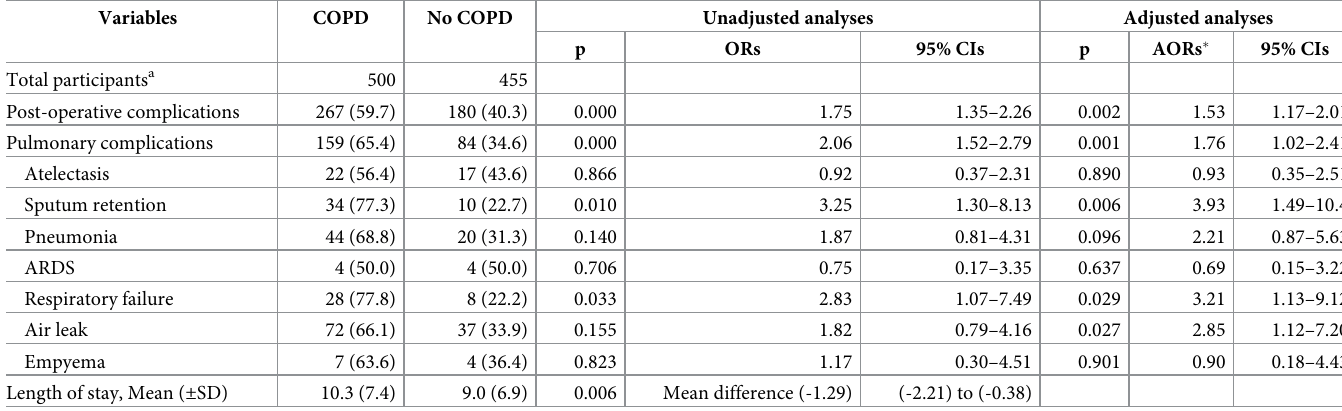
Table 3. Complication rates grouped by COPD status.